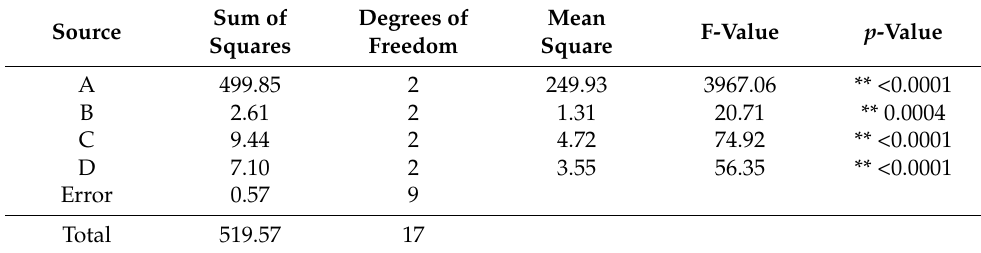
Table 3. Variance analysis and significance